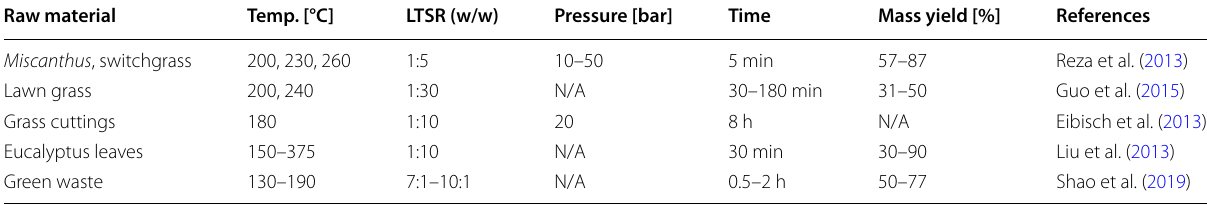
LTSR Liquid-to-solid ratio